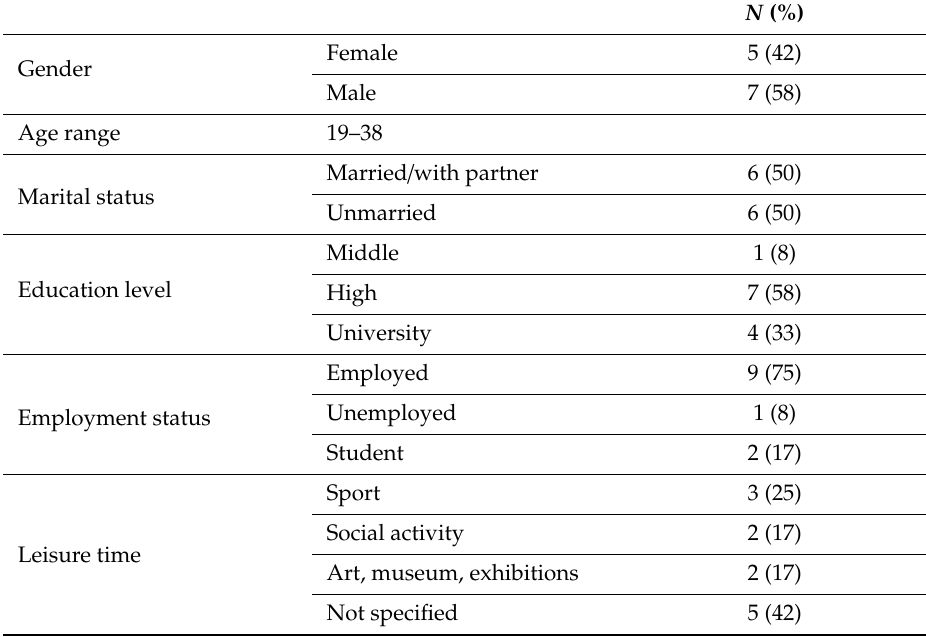
Table 2. Demographic characteristics of all